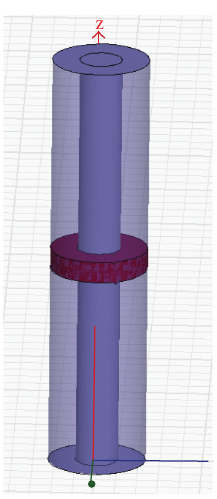
Figure 9: HFSS model of sample